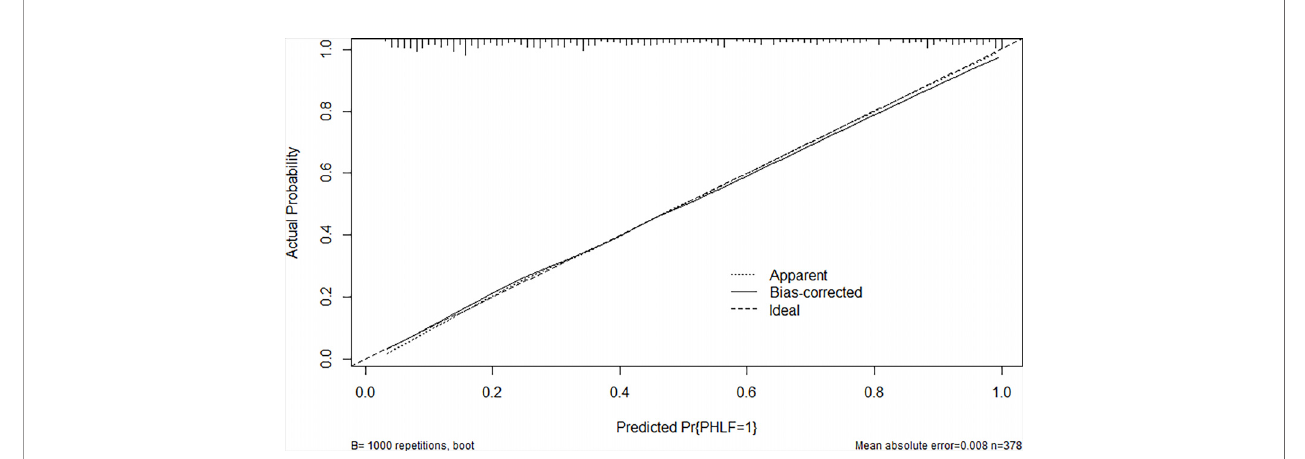
FIGURE 3 | The calibration curve of the nomogram in the training cohort. The x-axis indicates the nomogram predicted probability of PHLF, and the y-axis represents the actual PHLF rate. The dotted line represents a perfect prediction, and the solid line represents the predictive performance of this nomogram. The closer the solid line fi t is to the dotted line, the better the prediction of the nomogram will